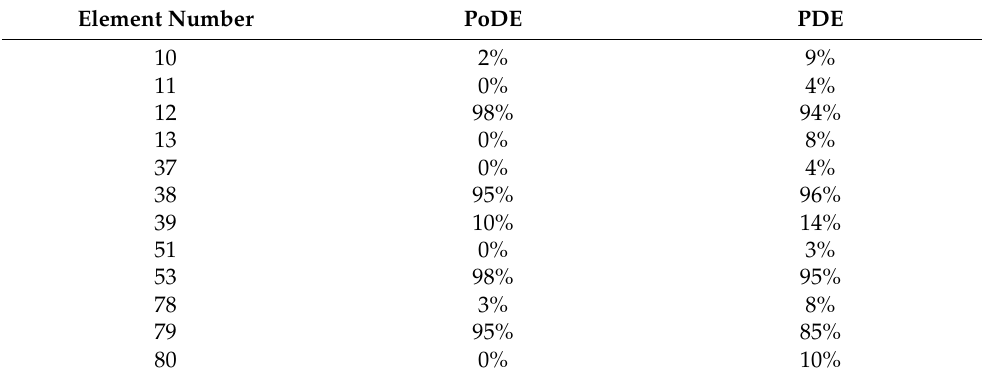
Table 8. PoDE for damage case 1 of the dome truss.